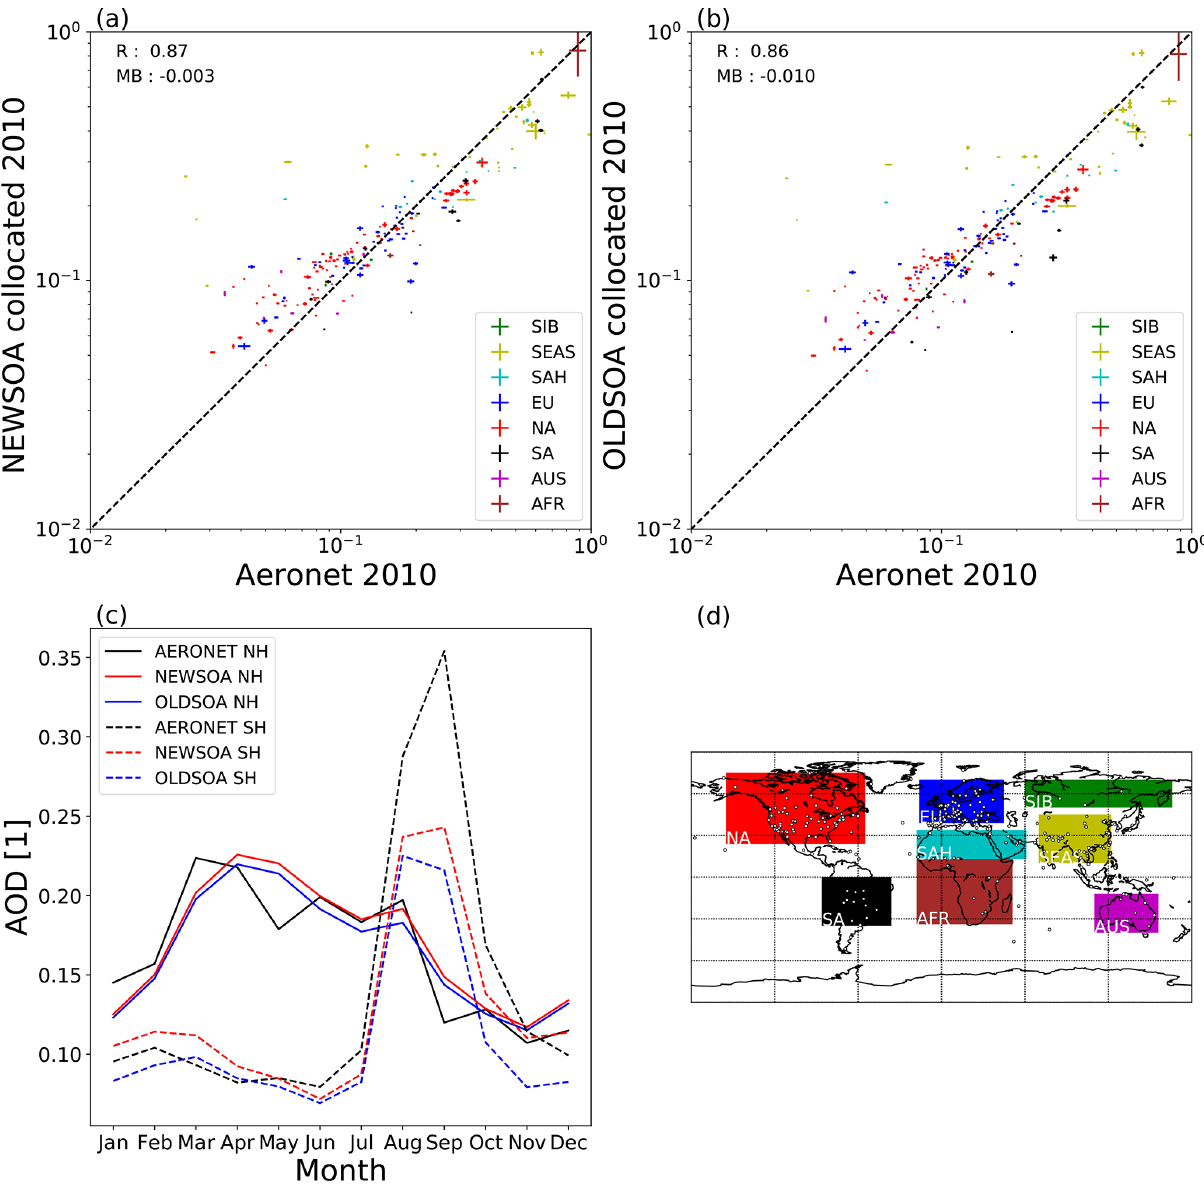
Figure 14. AOD at 550nm for the year 2010 from AERONET compared with collocated values from the simulations. The top panels show scatter plots of the retrieved and simulated annual mean values for (a) NEWSOA and (b) OLDSOA. Colours indicate different geographical locations. Plotted values show the standard error of the mean for both observed and modelled values, but errors are very small. Panel (c) shows the hemispheric seasonal cycle of the mean AOD across all AERONET stations with derived AOD in black, NEWSOA in red and OLDSOA in blue (Northern Hemisphere: solid line; Southern Hemisphere: dashed line). Panel (d) shows the locations of the observation stations and the areas used for grouping. The absolute mean bias (MB) and correlation coefficient ( R ) across all stations are annotated in panels (a) and (b)